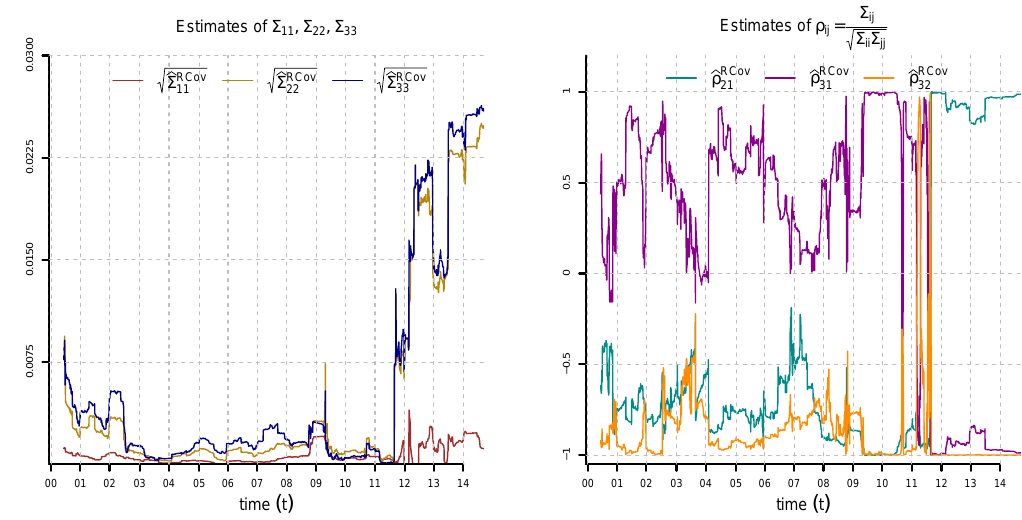
Figure 12. Estimation of Σ 11 , Σ 22 and Σ 33 (lhs) and correlations ρ 21 , ρ 31 and ρ 32 (rhs) by optimization (23) in the three-factor model for K = 126, M = 6, τ 1 = 1, τ 2 = 2, τ 3 = 5, τ 4 = 10, τ 5 = 21, τ 6 = 63 and w ij = 1 { i = j } . We observe large spikes in the volatilities and strong correlations among the factors during the European sovereign debt crisis and after the SNB intervention in